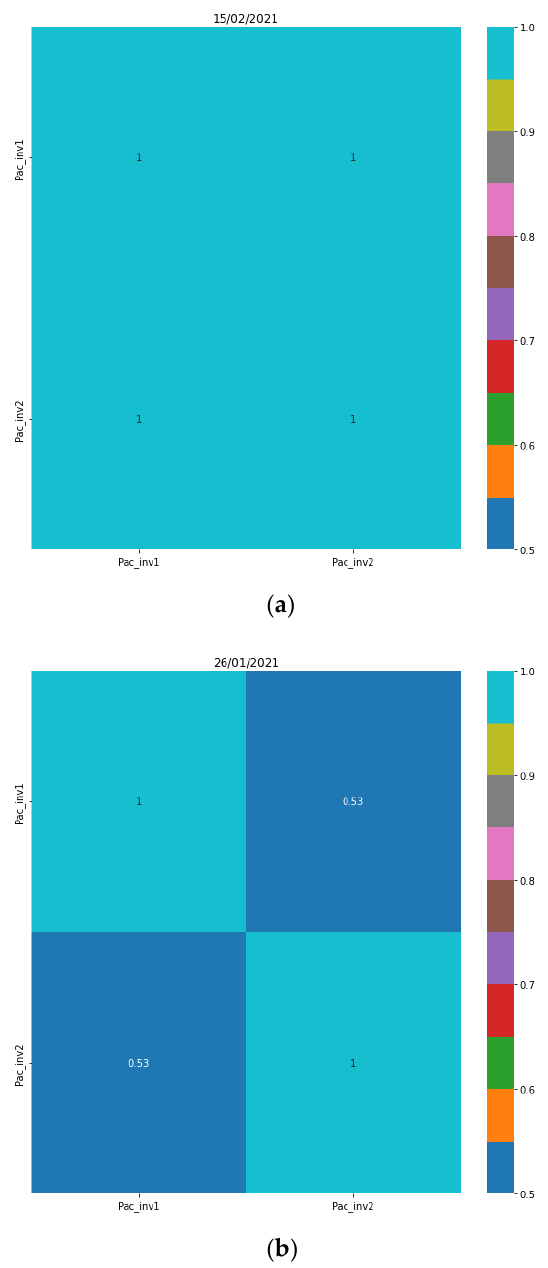
Figure 13. Graphical representation of the correlation index matrix between P ac values for inverters 1 and 2 of plant 1 on 15 February 2021 ( a ) and 26 January 2021 ( b ).